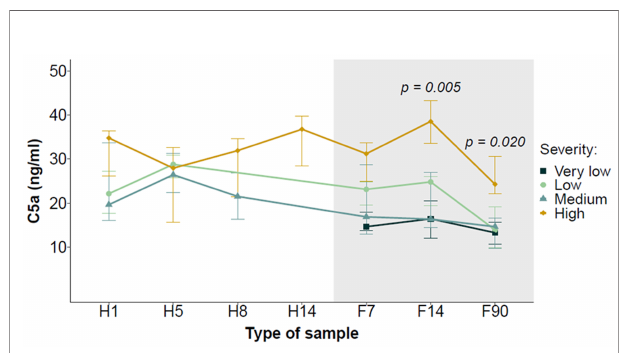
FIGURE 2 | Evolution of serum C5a levels during hospitalization and follow- up in COVID-19 patients strati fi ed by the severity of the disease. Serial samples were collected at different time points during the hospitalization period (H1, H5, H8 and H14) and the follow-up (F7, F14 and F90). Data are presented as median ± interquartile range. The shadowed area corresponds to the follow-up period. Differences between groups at each time point were analyzed using the Kruskal-Wallis test.